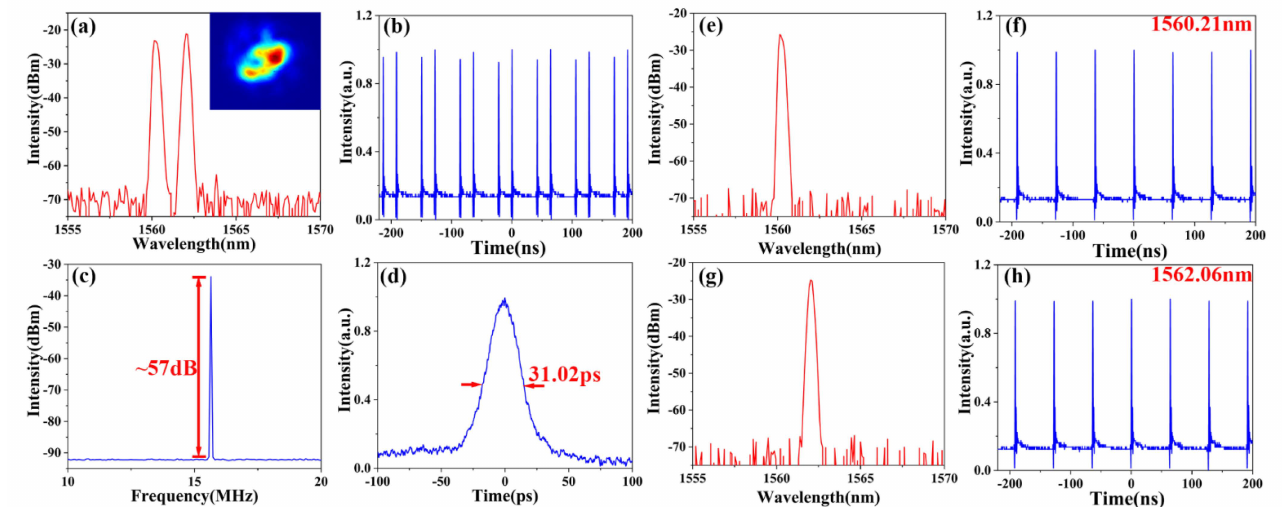
Figure 2. The dual-wavelength STML state at 160 mW: ( a ) the spectrum, inset: beam spot; ( b ) the pulse-train; ( c ) the RF spectrum; ( d ) the autocorrelation trace; ( e , f ) the filtered spectrum and pulse- train at the central wavelength of 1560.21 nm, respectively; ( g , h ) the filtered spectrum and pulse-train at the central wavelength of 1562.06 nm,